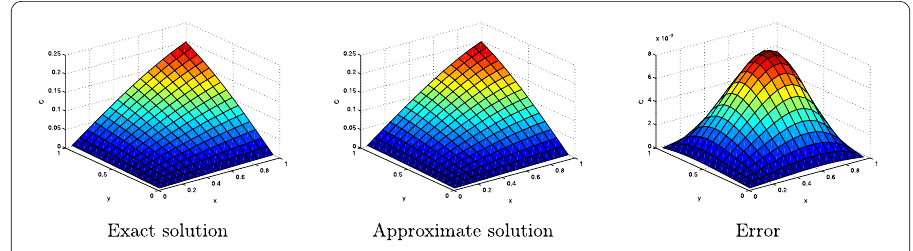
Figure 4 Graphical behavior of Example 5.4 when t = 0.1, γ = 0.9